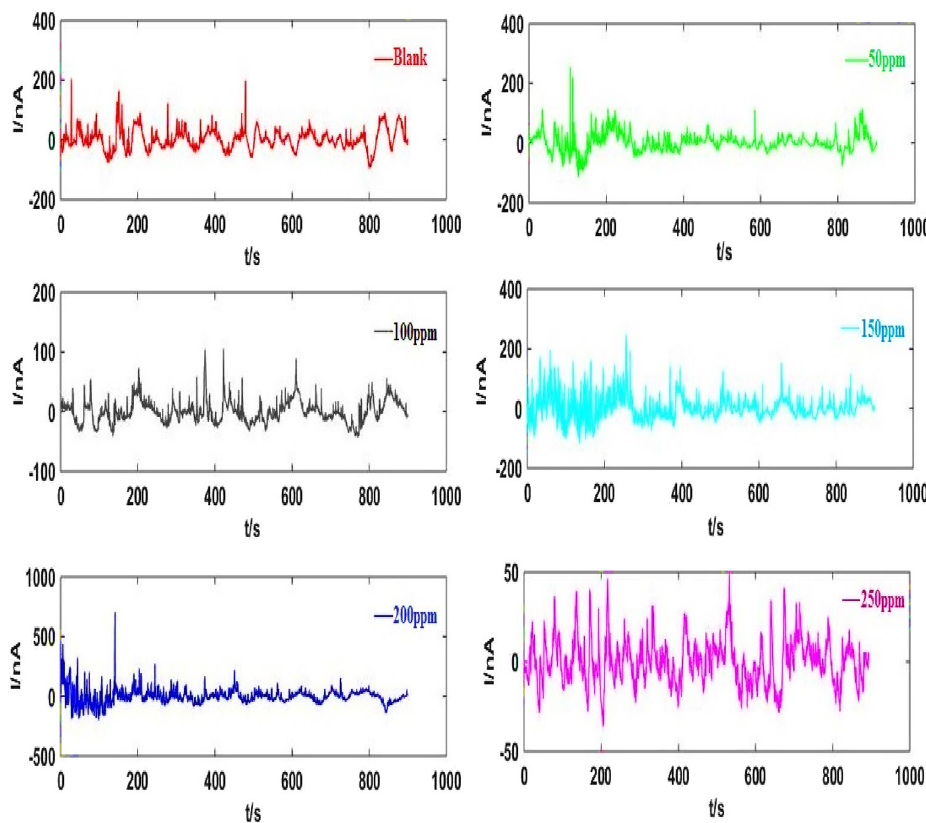
Figure 5. EN current records illustrated in Fig. 4, after elimination